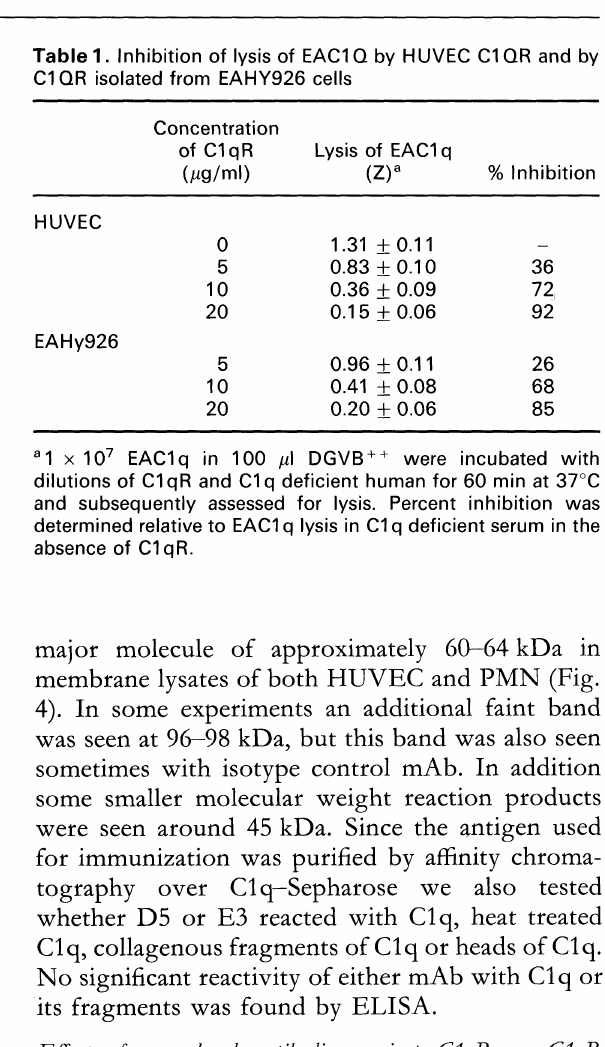
Table 1. Inhibition of lysis of EAC1Q by HUVEC C1QR and by C1QR isolated from EAHY926 cells Concentration of ClqR